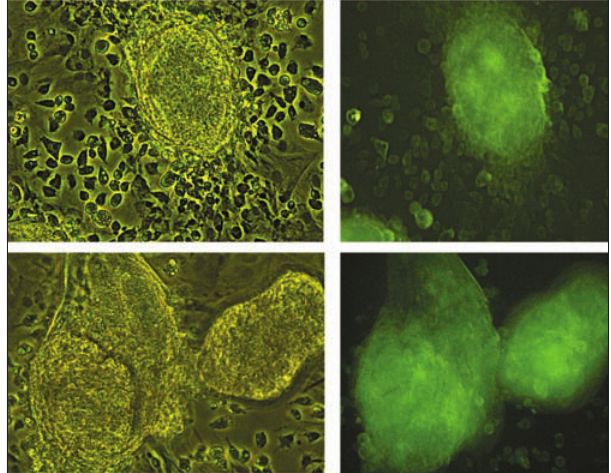
Fig. 3.- Immunohistochemical highlighting of osteopontin positive cells and